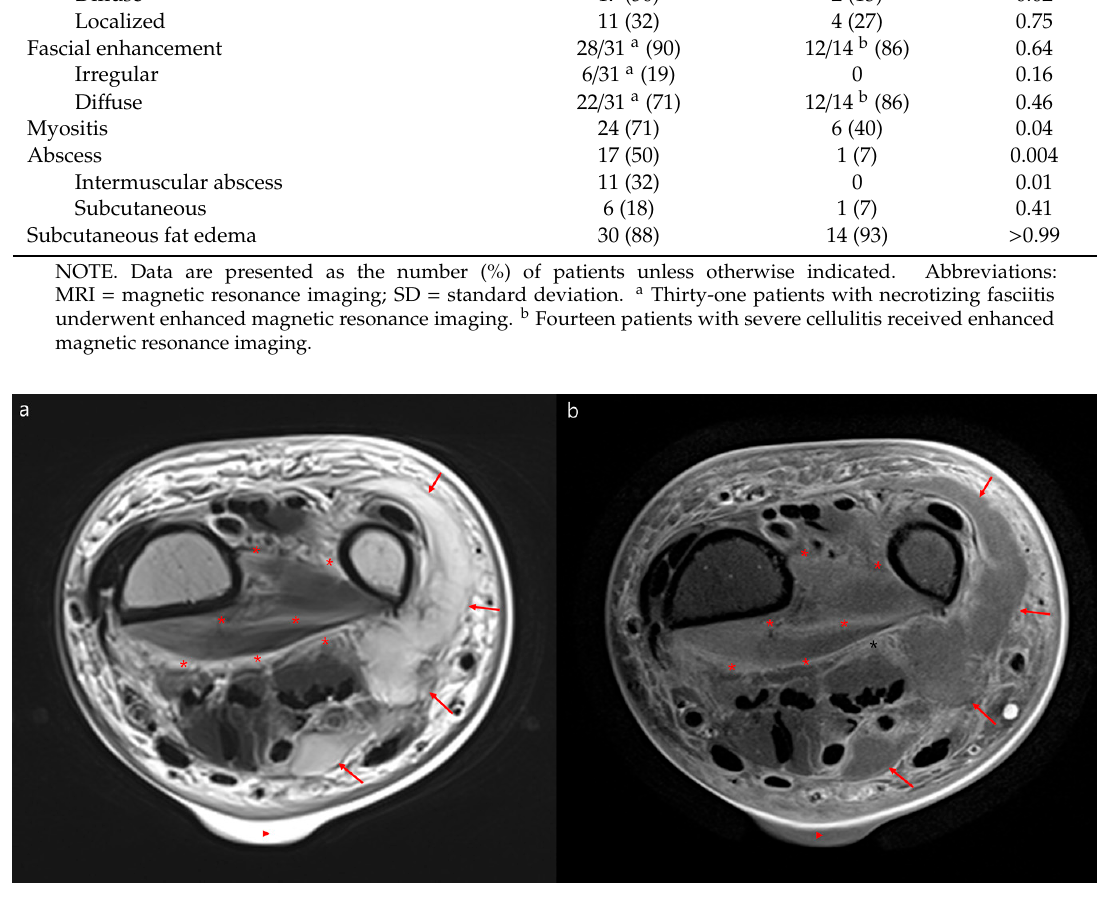
Figure 2. Representative magnetic resonance images of necrotizing fasciitis. Necrotizing fasciitis of the left wrist in a 71-year-old woman. Axial T2 weighted magnetic resonance image ( a ) and contrast-enhanced magnetic resonance image ( b ) showing diffuse hyperintensity with irregular enhancement of the deep peripheral fascia and intermuscular deep fascia (asterisk) of the wrist. Additionally, there is a lobulating abscess in the ulnar side of the wrist (arrows) and a skin bulla (triangle).